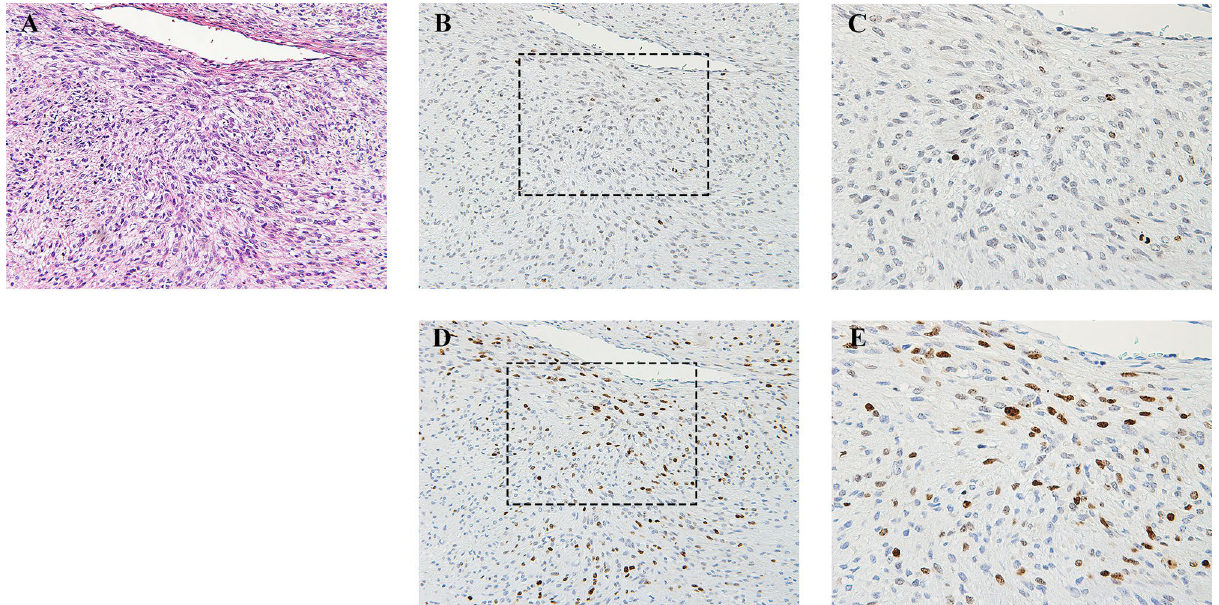
Figure 1. Immunohistochemical expression of PHH3 and Ki-67 in an MLS patient showing the PHH3 index of 2.1% and Ki-67 index of 31.3%. ( A ) H & E (X100), ( B ) PHH3 (X100), ( C ) PHH3 (X200), ( D ) Ki-67 (X100), ( E ) Ki-67 (X200).